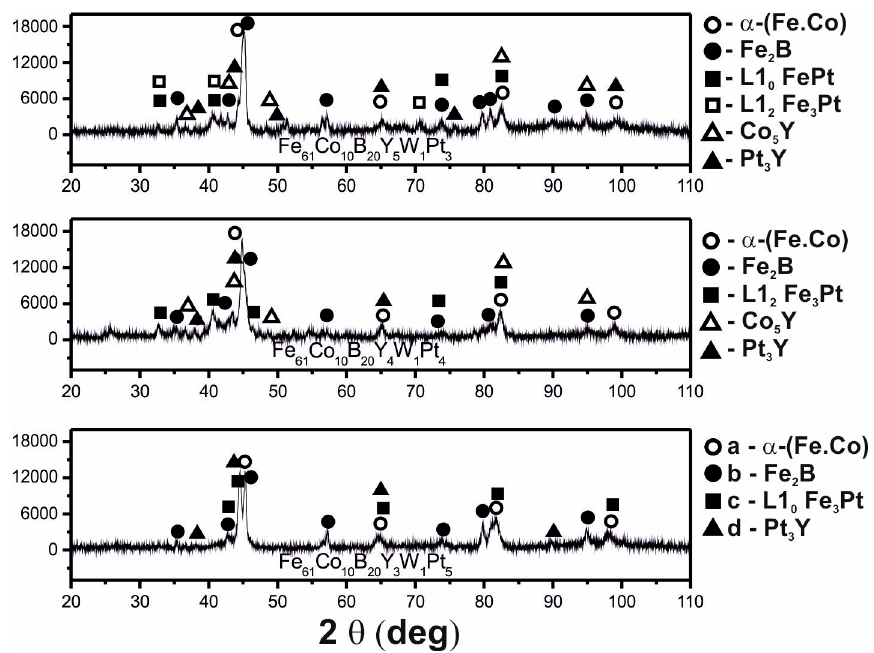
Figure 1. X-ray diffraction patterns for the plate-form samples of the investigated alloys.